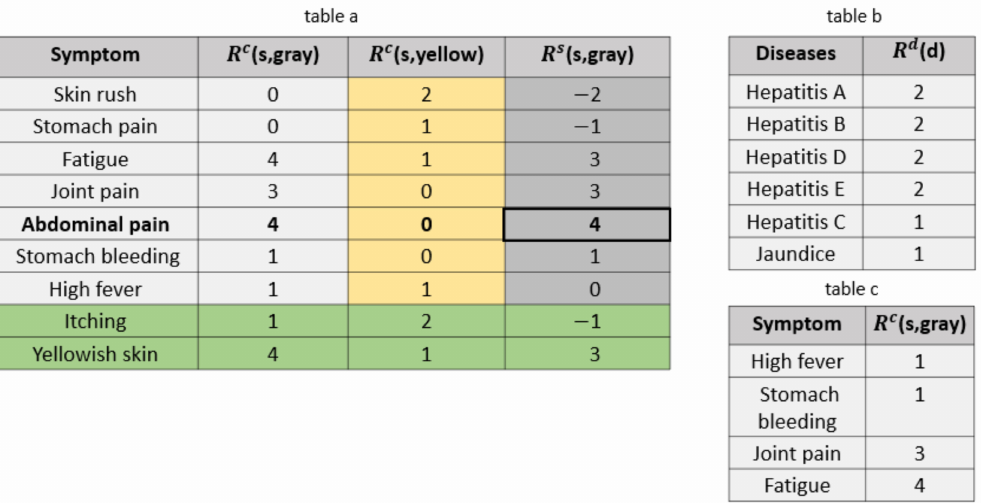
Figure 6. Table A—the Symptom’s R c for each PD’s community along with the R s for the gray community; Table B—the diseases in the gray community with their R d ; Table C—the symptoms indicating the gray diseases with their R c